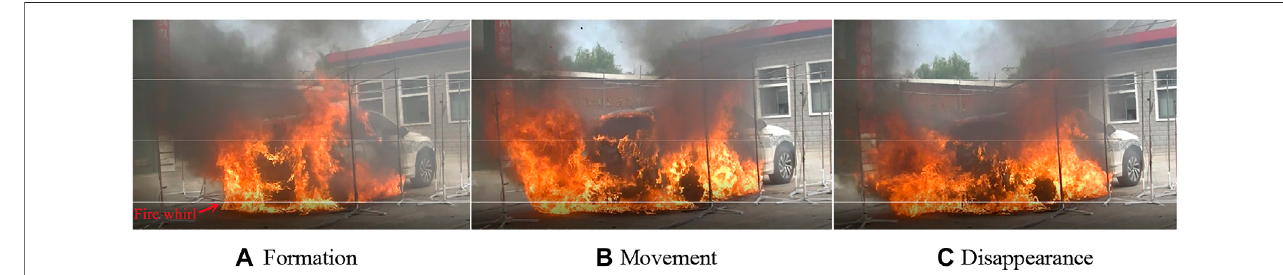
FIGURE 12 | Formation of a fi re whirl during test 1. (A) Formation (B) Movement (C)